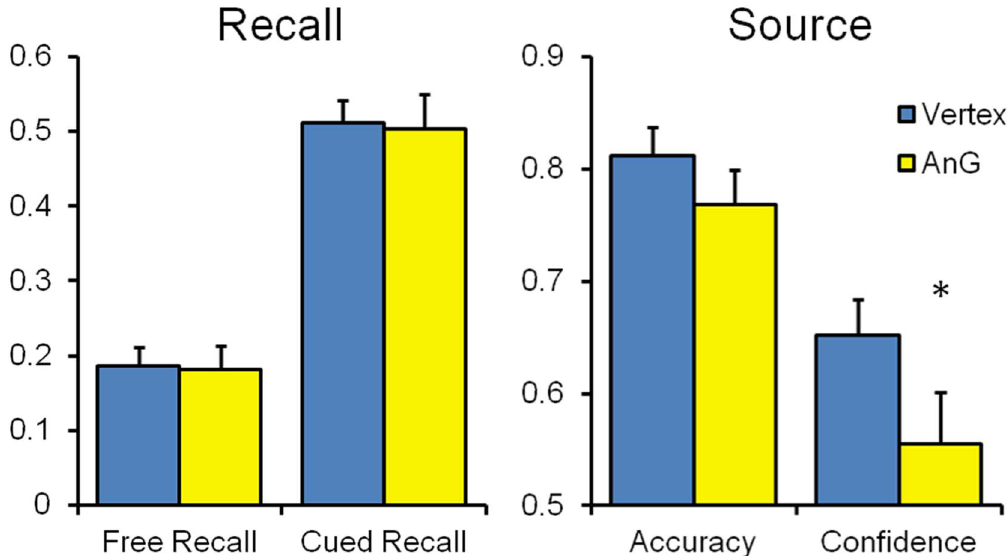
Figure 3. Performance of the groups who received cTBS targeting vertex and angular gyrus (AnG) on free and cued recall (left panel) and source recollection accuracy and confidence (right panel). Error bars denote standard error of the mean.